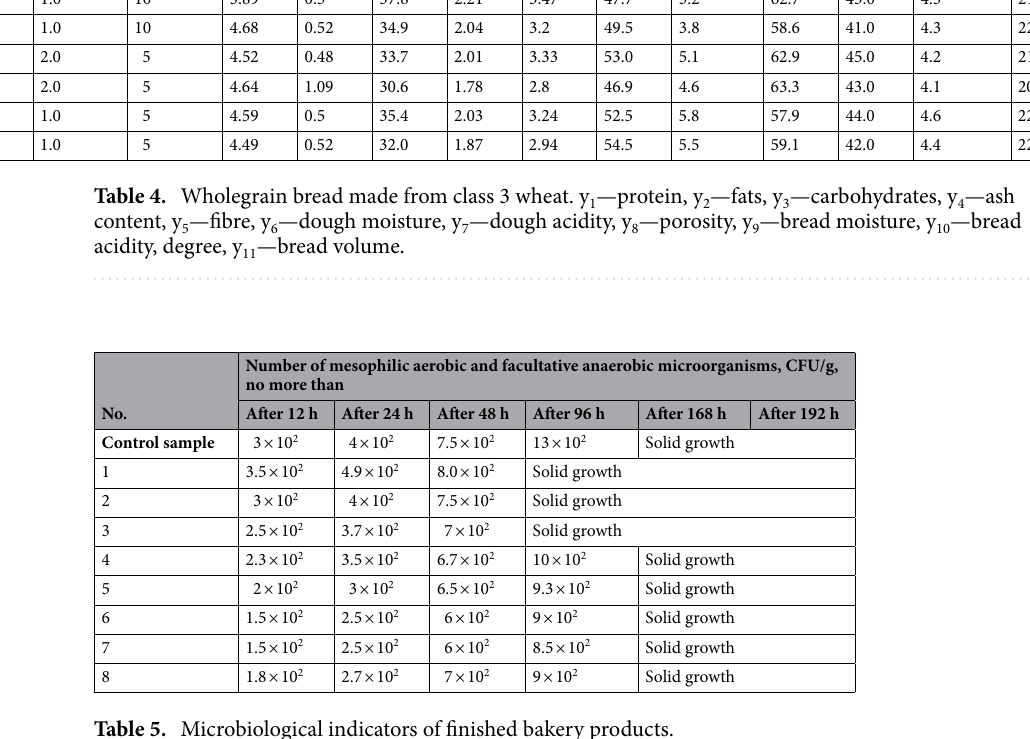
Table 5. Microbiological indicators of finished bakery